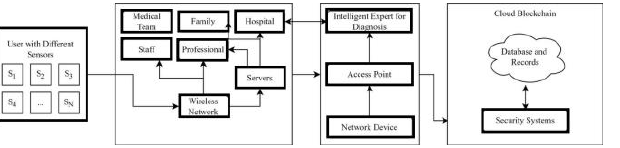
Figure 3. Proposed Architecture